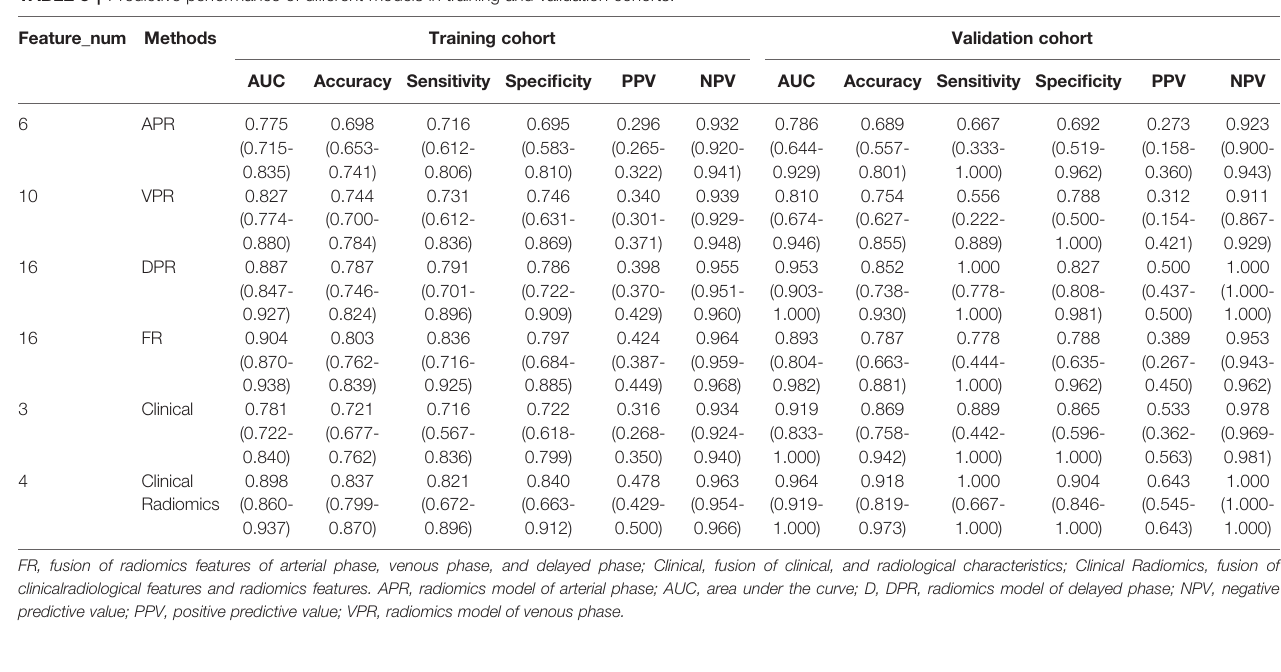
TABLE 3 | Predictive performance of different models in training and validation cohorts.